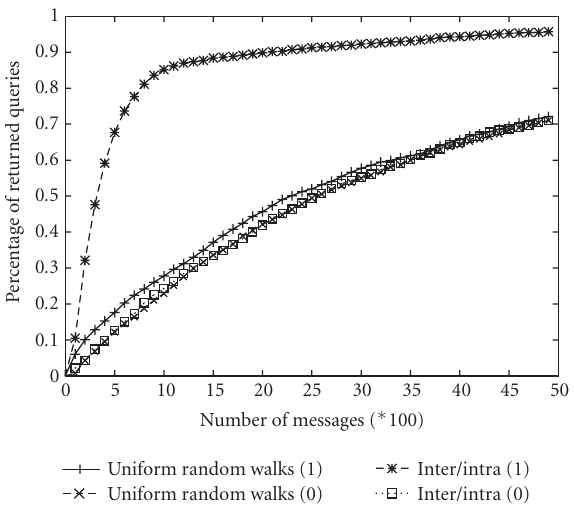
Figure 9: The percentage of returned query within a specific hop number in a less-clustered network.